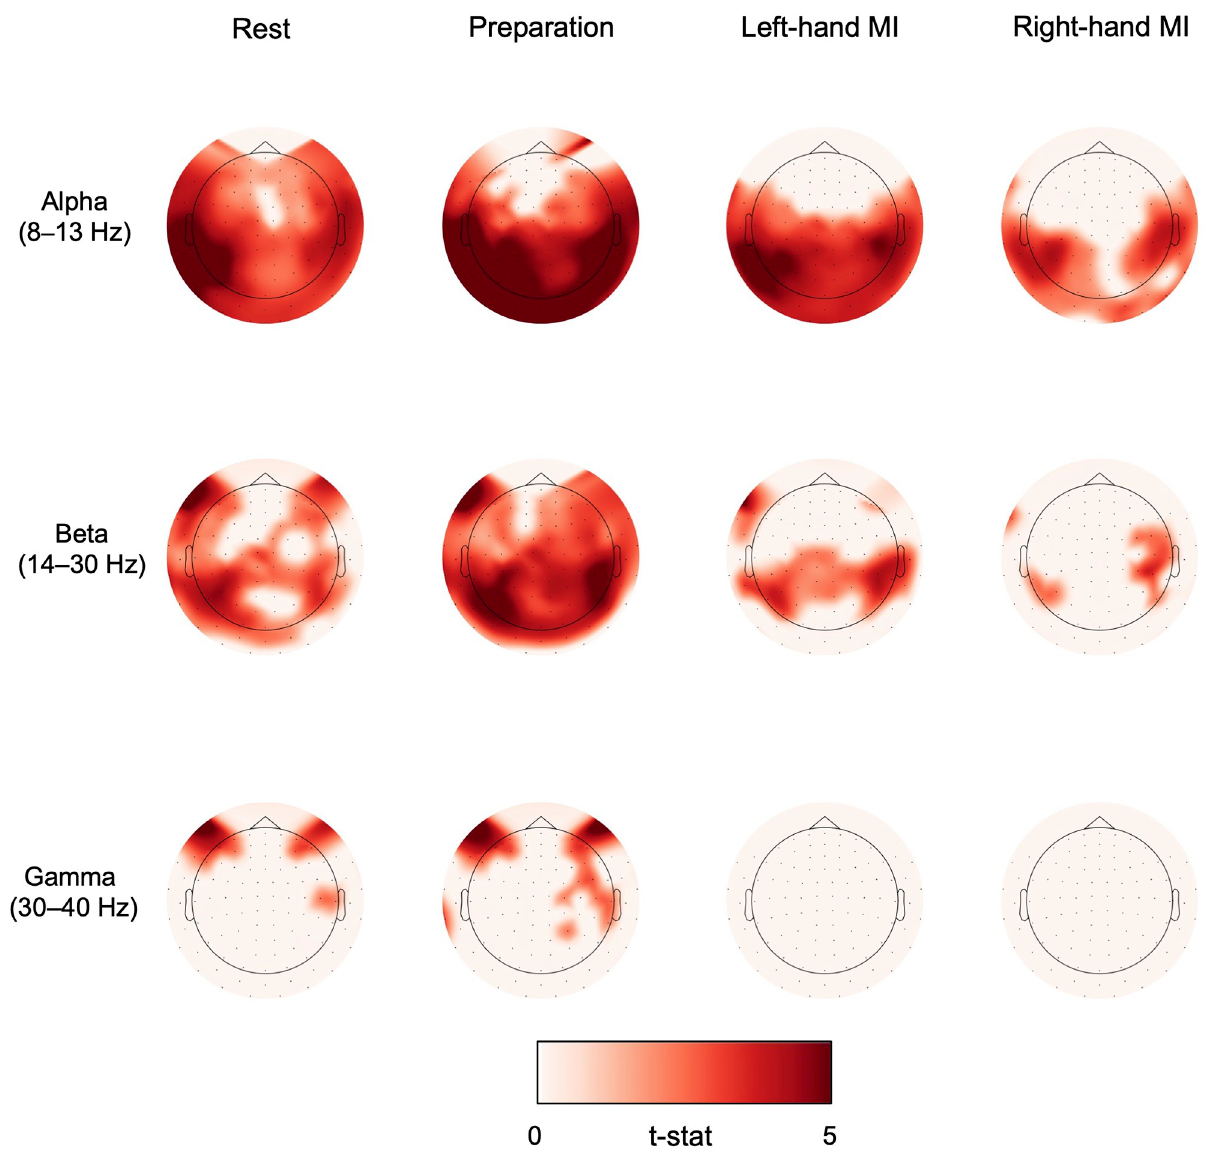
Fig 7. Channel-specific power increase in Data 2. MEG gradiometers in which a linear power increase over trials was statistically significant ( t -statistic shown for channels in which p < 0.05) for alpha-, beta- and gamma-band oscillations when delivering proprioceptive feedback (Data 2).